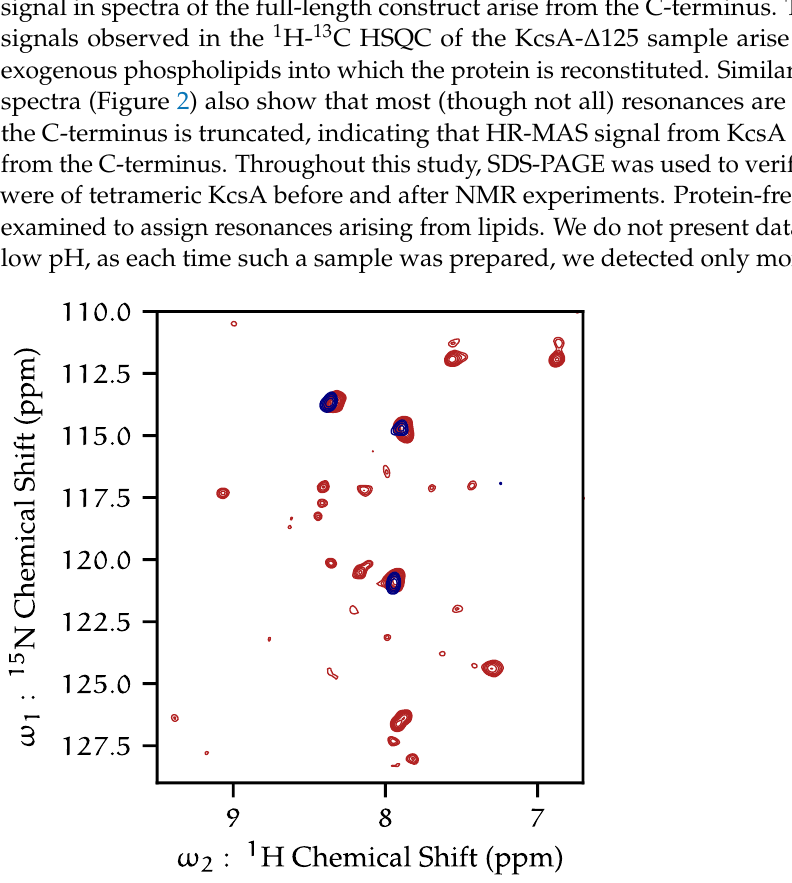
Figure 2. 1 H- 15 N HSQC by HR-MAS of full-length wild-type KcsA (red), and KcsA- ∆ 125 (navy); both samples pH 7.25, 50 mM K + , 308 K, 5 kHz MAS.